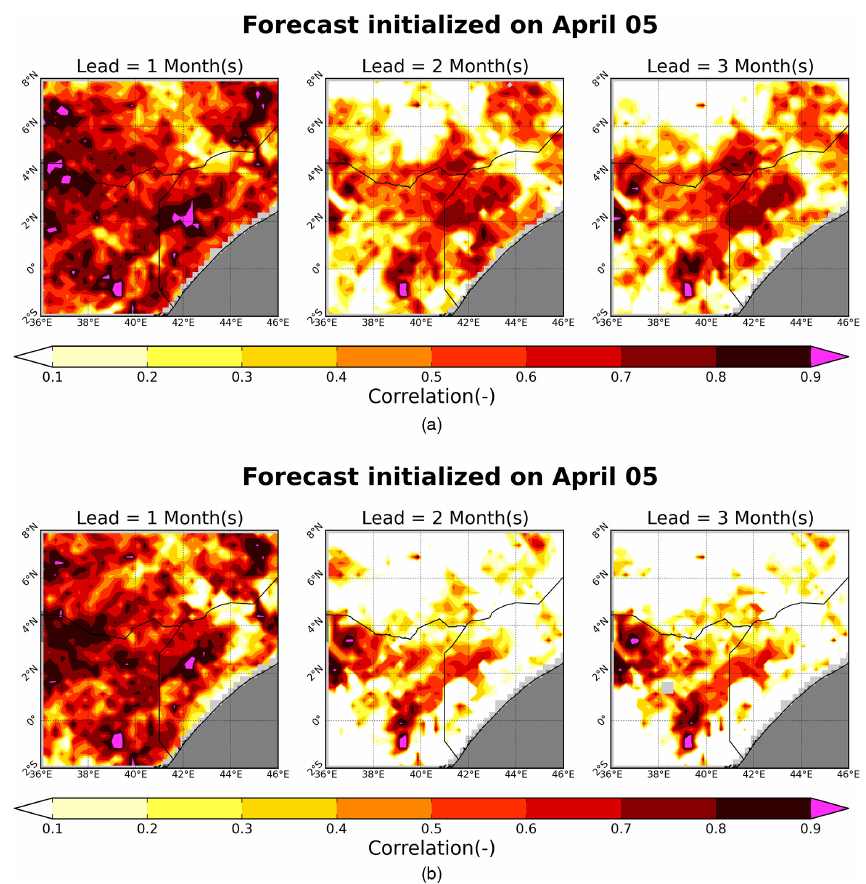
Figure 9. Same as in Fig. 8 but for forecasts initialized on 5 April (middle of